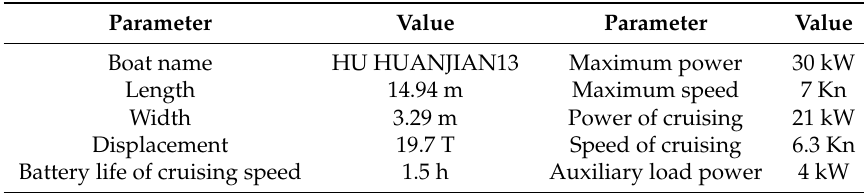
Table 1. Main parameters of the